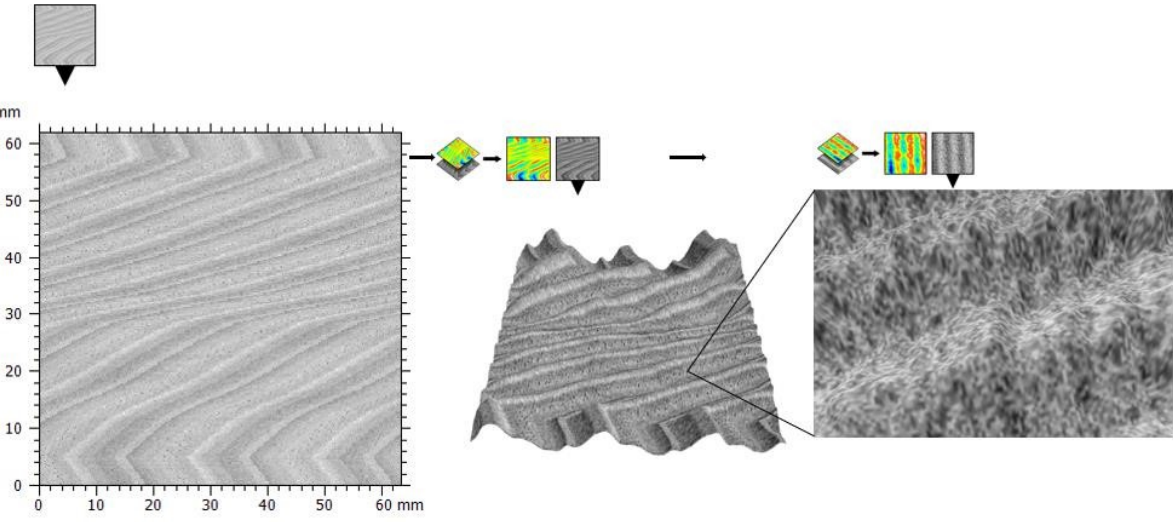
Figure 13. TiO 2 scaffolds in presence of pork bone.